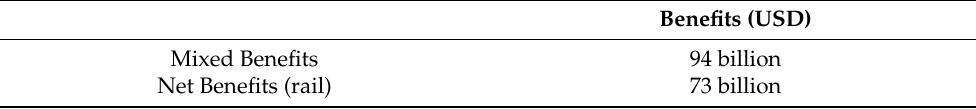
Table 4. The benefits of intercity rail speed increase project (ABM).